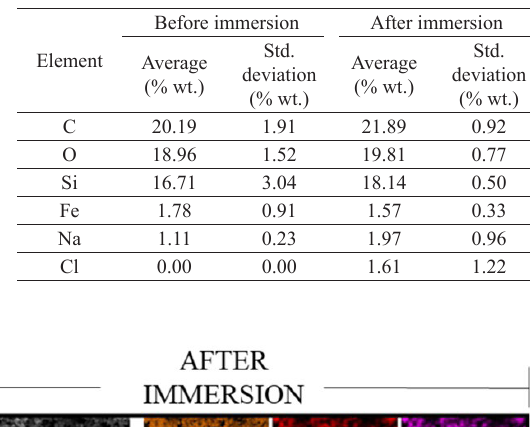
Table 2. Elemental mass percentage on the superhydrophobic coatings before and after 48 hours of immersion in NaCl 3.5%